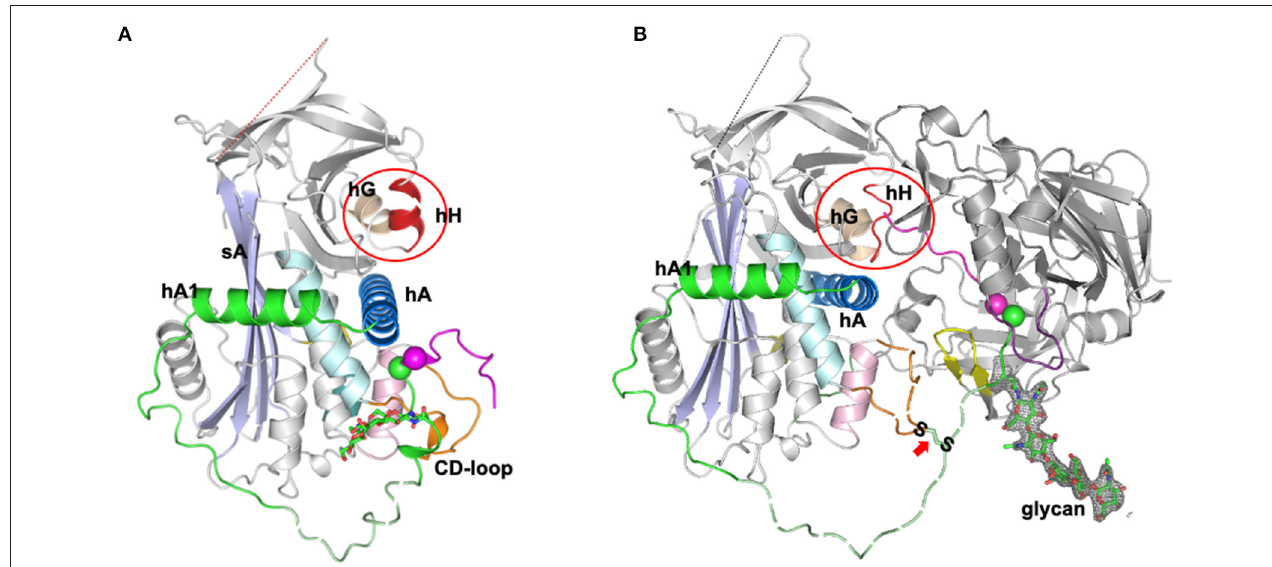
FIGURE 2 | Tail-into-mouth shift of N-terminal tail on binding with Renin (10). (A) Side view of angiotensinogen showing the rearrangement of the tail (magenta and green) that takes place on the complexing with renin in (B) . The scissile bond, Leu10-Phe11 (magenta and green spheres) becomes exposed and the tail is anchored at its terminus by docking into what in other serpins is the hormone-binding pocket, between helix H, the B beta-sheet, and helix A (as circled). Docking of the terminus is accompanied by an unfolding of helix H to reveal sidechains essentially involved in the binding of renin. The S-S bridge between Cys18 of the tail and Cys138 of the displaced CD loop of angiotensinogen is arrowed. Also apparent: the potential influence on cleavage kinetics of glycan variations at Asn14, adjacent to the scissile bond. The clear electron density for the glycan linked to Asn14 is shown in gray mesh and the fragments without clear electron density are shown with dashed lines for illustration. The figure was adapted from our previous publication (10) with